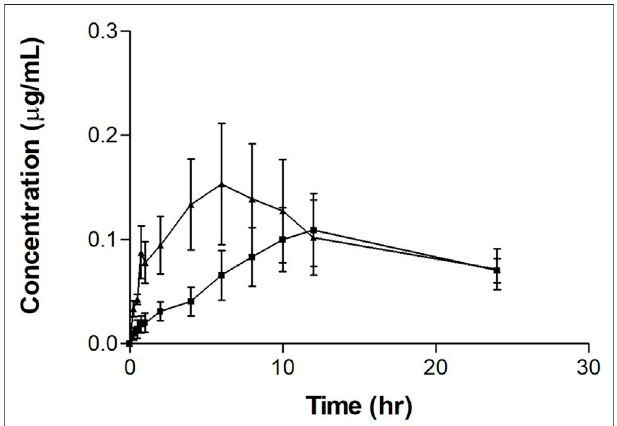
FIGURE 1 | Mean serum concentration-timepro fi les of tamoxifen after a single oral dose of tamoxifen (20 mg/kg on day 8) ( ▲ ) with or without PSP extract (pretreatment 340 mg/kg orally for 7 days) ( ■ ) in female Sprague- Dawley rats. Each point represents as the mean ± SEM ( n = 5). Note: timepoints at 10, 12, and 24 h are n = 4 for tamoxifen plus PSP extract.